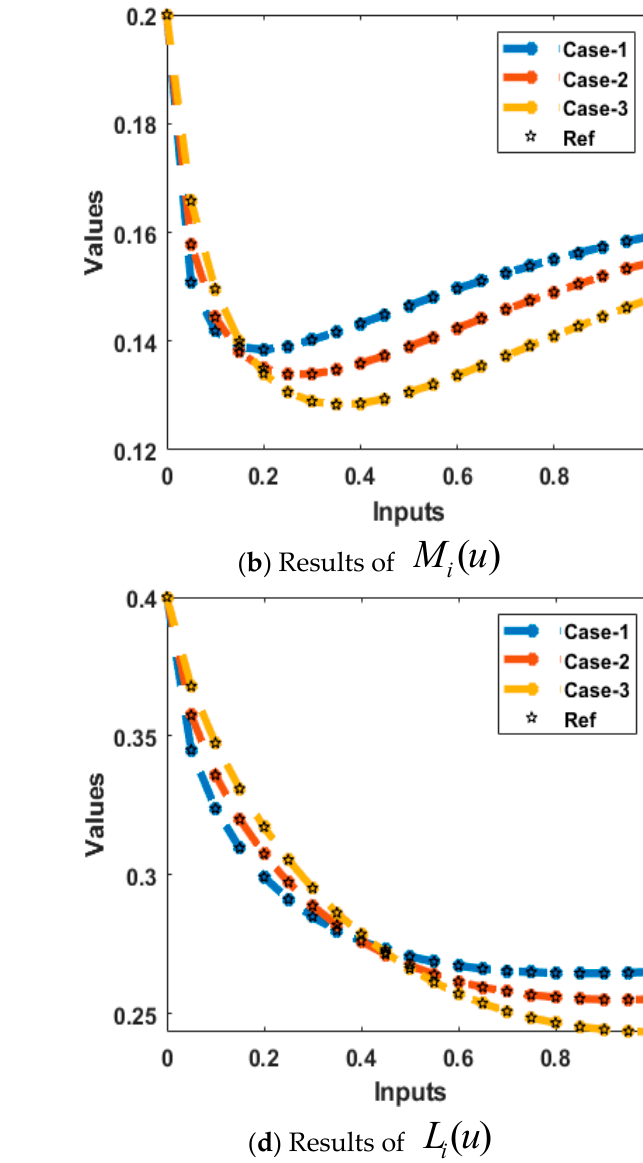
Figure 6. Comparison of the achieved performances along with the reference solutions to solve the FO-MML love story model.